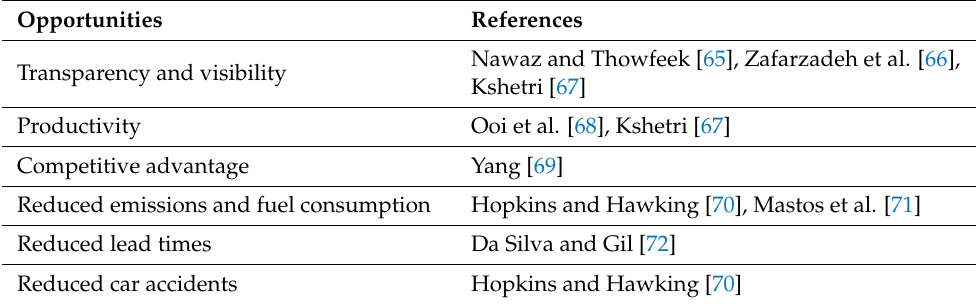
Table 4. Opportunities for digitalization in the logistics chain.